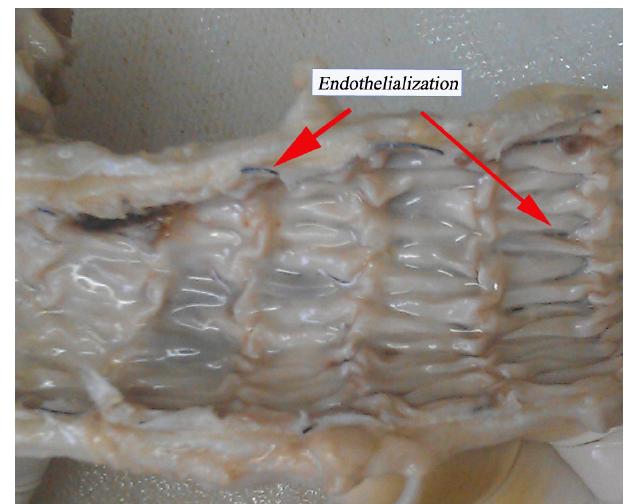
Fig. 6 - Thoracic aorta implanted with